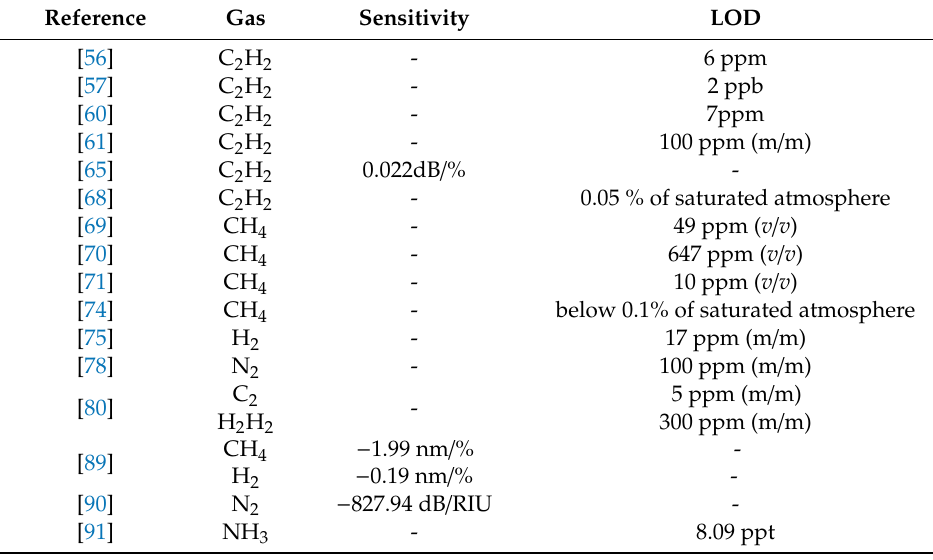
Table 1. Comparative table showing the most relevant features of MOF gas sensors listed in Section 3.